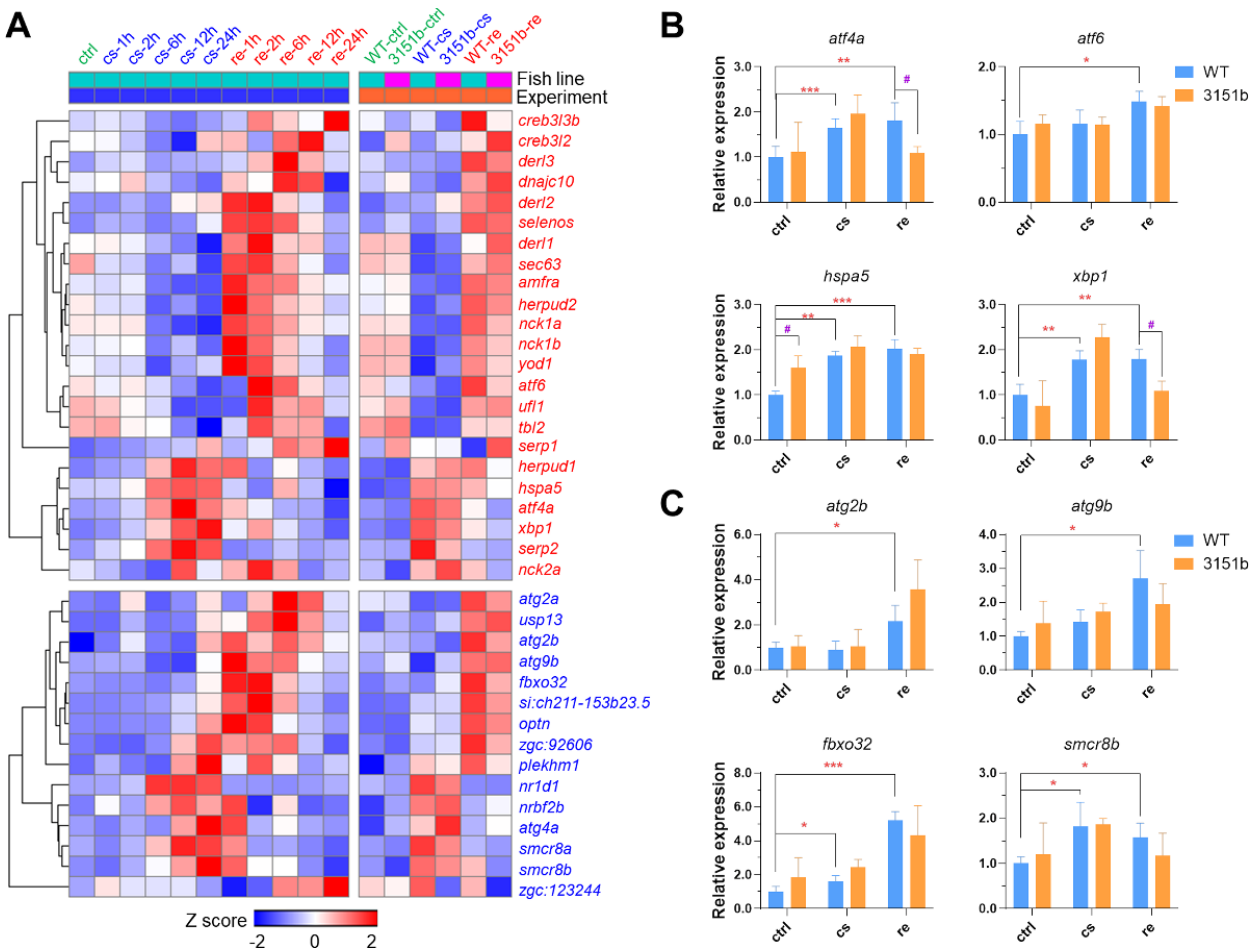
Figure 7. Effects of Tmem39b dysfunction on endoplasmic reticulum stress response and autophagy. ( A ) A complex heatmap indicating the transcriptional expression of genes involved in endo ‐